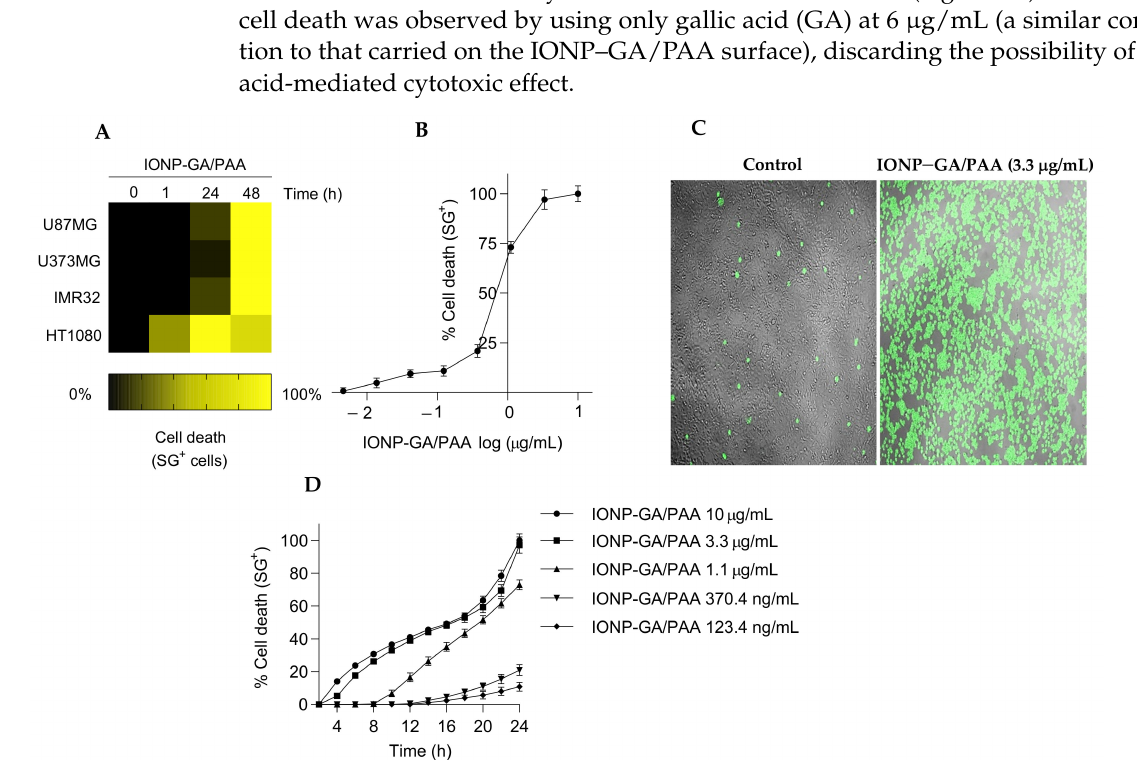
Figure 3. IONP–GA/PAA induce cell death in a panel of cancer and non-tumorigenic cell lines. ( A ) Heatmap representing cell death sensitivity of various cancer cell lines after exposure to IONP– GA/PAA (3.3 µ g/mL): HT22 (mouse hippocampal neuronal cell line), U87MG and U373MG (human glioblastoma cell lines), IMR32 (human neuroblastoma cell line), and HT1080 (human fibrosarcoma cell line). Each cell line was incubated with IONP–GA/PAA for 48 h. ( B ) Dose-effect curve of the effect of IONP–GA/PAA on HT1080 cell line during 24 h. ( C ) Snapshots from live-cell imaging of untreated (control) and IONP–GA/PAA-treated cells (3.3 µ g/mL, 24 h). Green fluorescent staining represents SytoxGreen dye. ( D ) Kinetic profile of the effect of several concentrations of IONP–GA/PAA